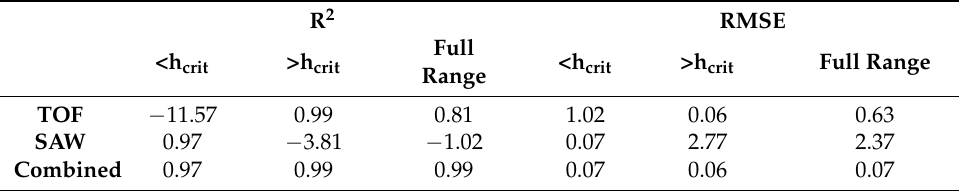
Figure 6. Relationship between predicted levels with TOF using one transducer in reflection mode and reference (volumetric determination). R 2 = 0.81 and RMSE = 0.63 (N = 5). Table 2. Summary of the R 2 and RMSE of the models for the particular filling